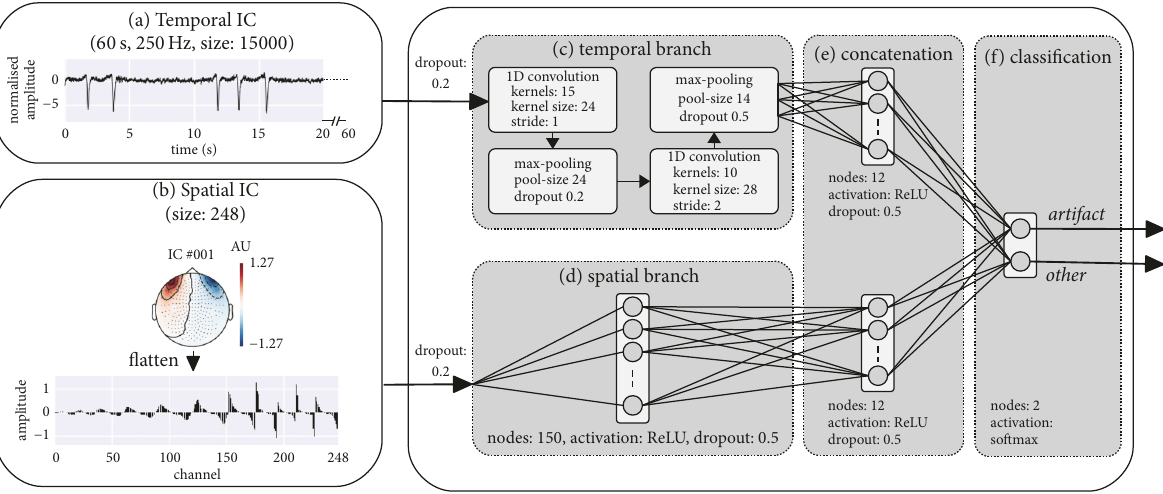
Figure 2: Architecture of the neural network model with an example of a typical ocular artifact component. The model is trained using the temporal (a) and spatial (b) information simultaneously, passing it through the different input branches (c) and (d). Features from both domains are extracted (e) and passed into a 2-node layer (f) for